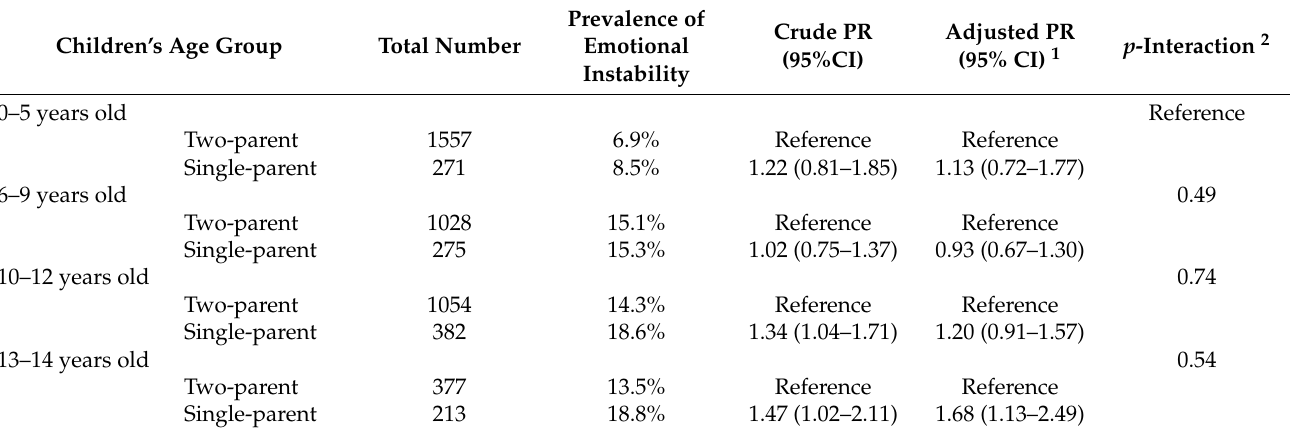
Table 3. Family type and children’s emotional instability: stratified by children’s age ( n = 3358).